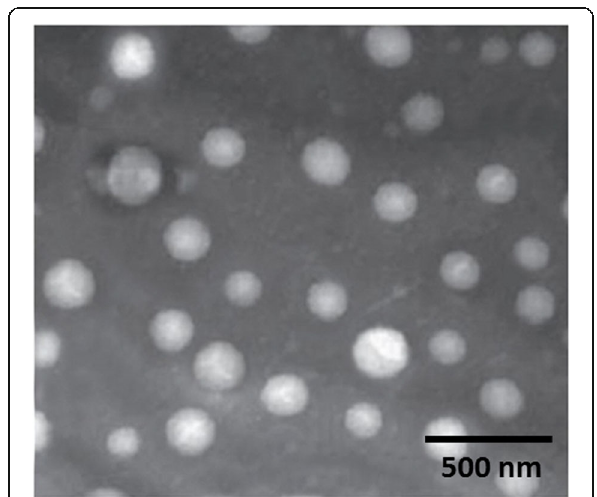
Fig. 2 Transmission electron microscope of